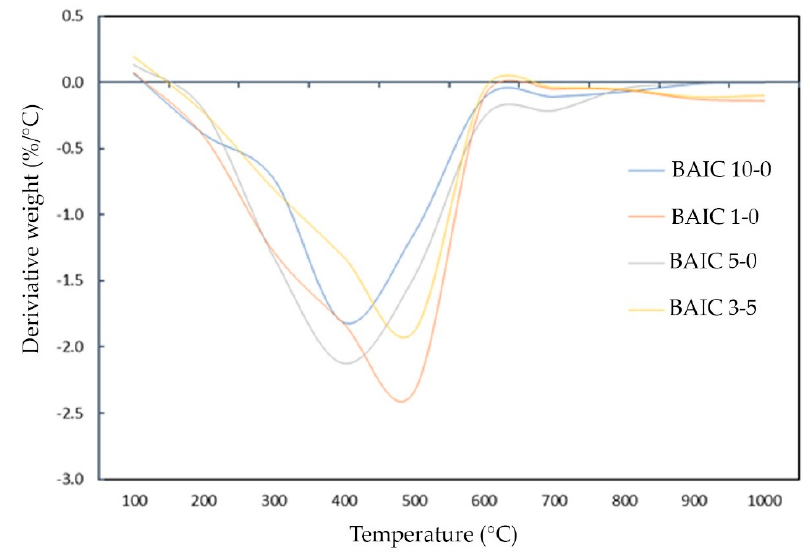
Figure 6. Derivative thermogravimetric analysis (DTG) of BAIC samples.